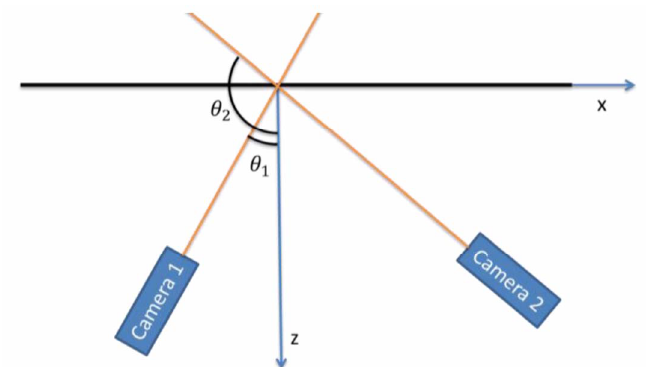
Figure 2 - Schematic showing the angles used to calculate the displacement vectors within the x-z